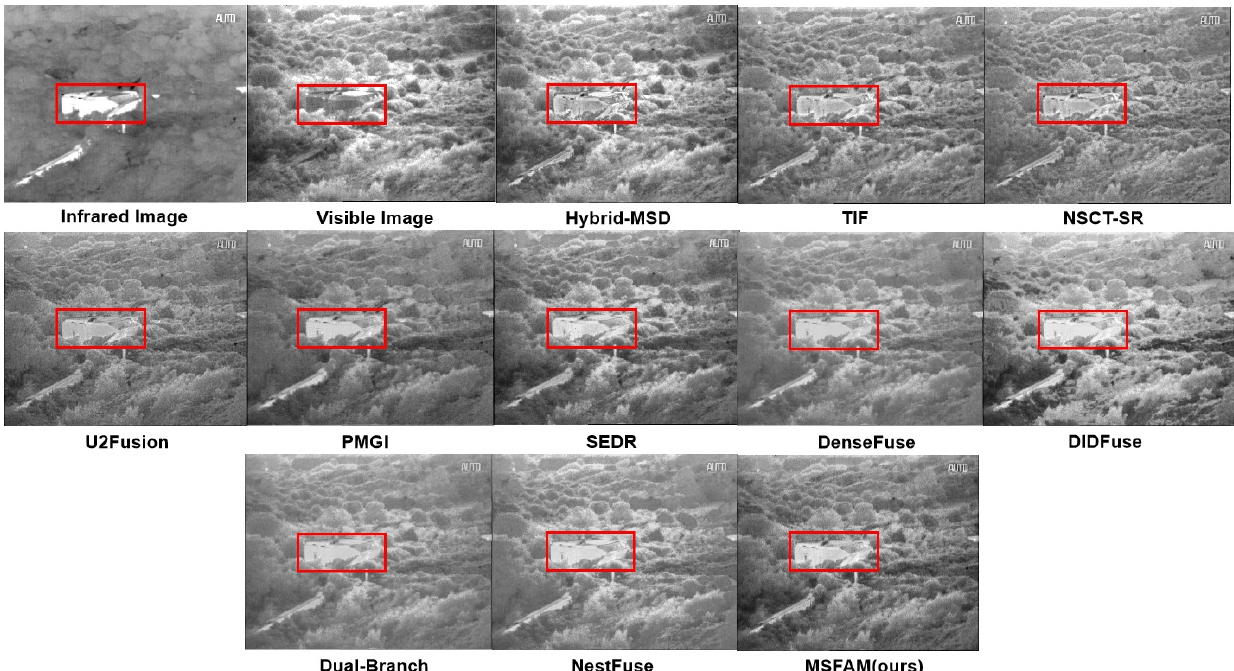
Figure 9. Experimental results of various methods on the “bunker” images. Red square represents for the areas that need to be focused.